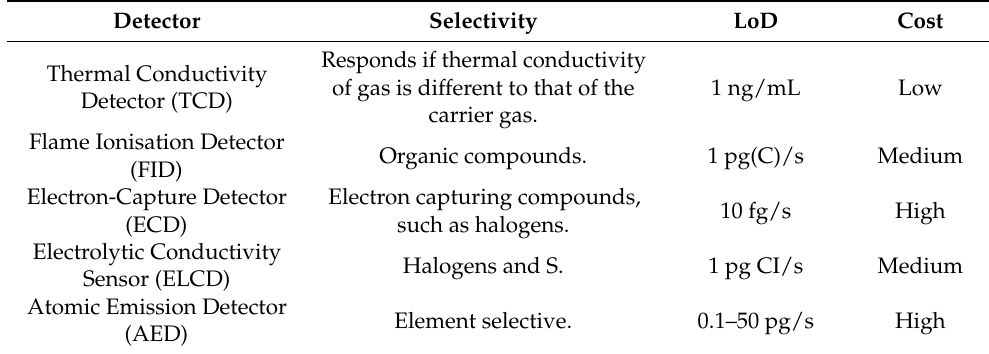
Table 3. A table summarising some typical characteristics for the most common GC detectors that are used in applications and